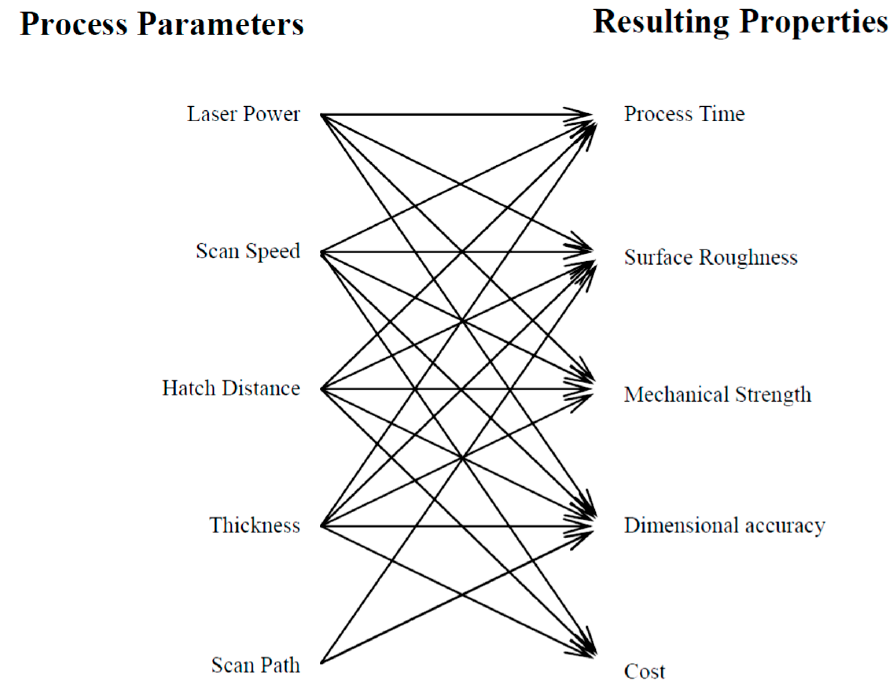
Figure 1. The influence of sintering parameters on final properties of material in DMLS technology [23].